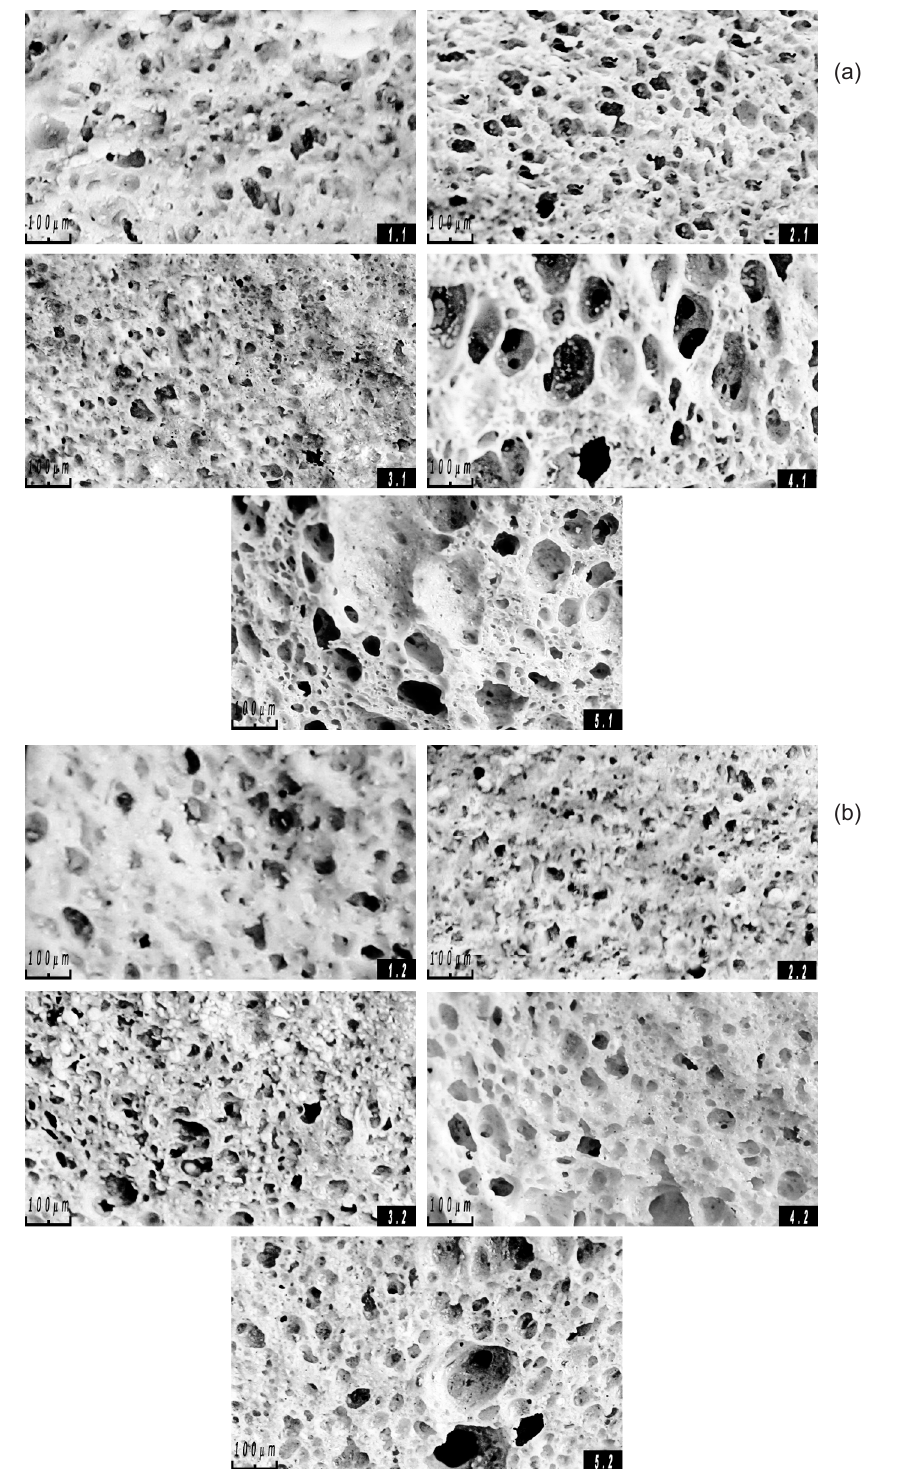
Figure 1. Microscopic images (reflected light) of samples cross-sections: (a) using window panes wastes; (b) using bottle glass